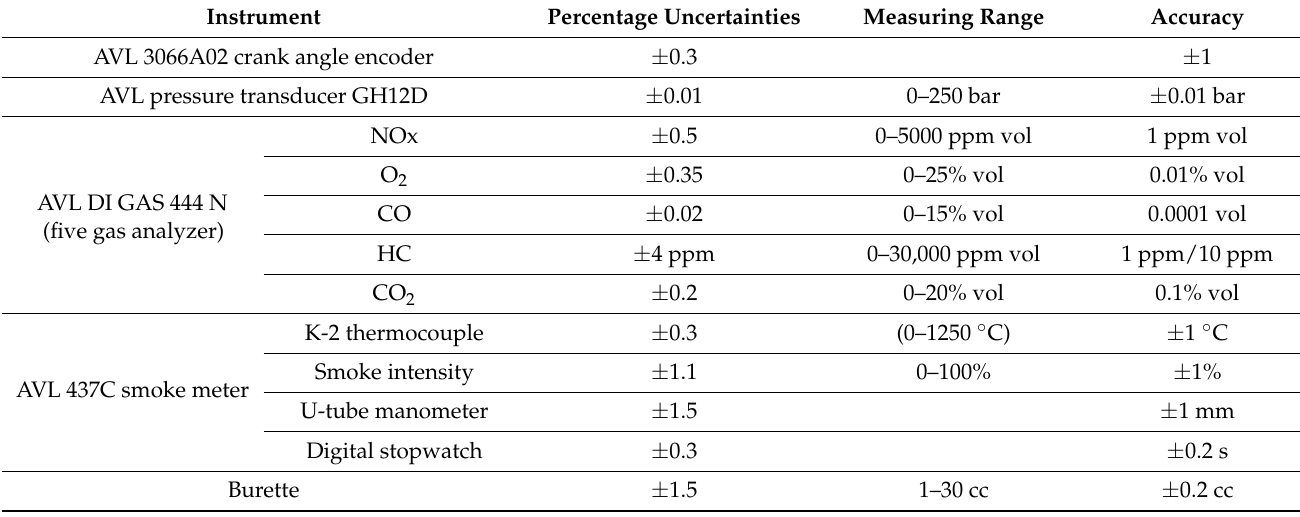
Table 5. Instruments uncertainty percentage and accuracy and its measuring range.